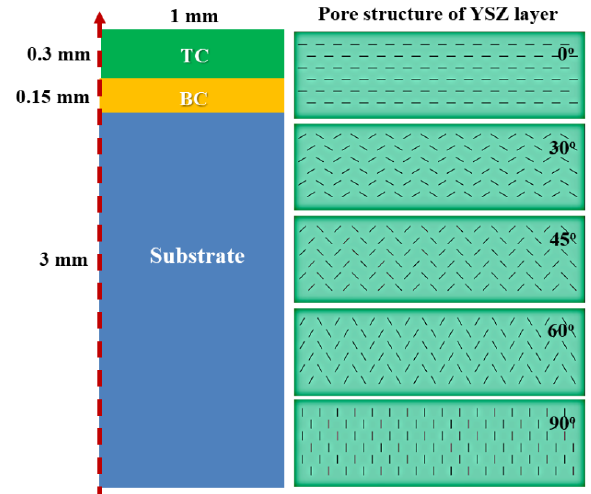
Figure 4. Schematic illustration of a TBC specimen and its pore structure in TC layer.